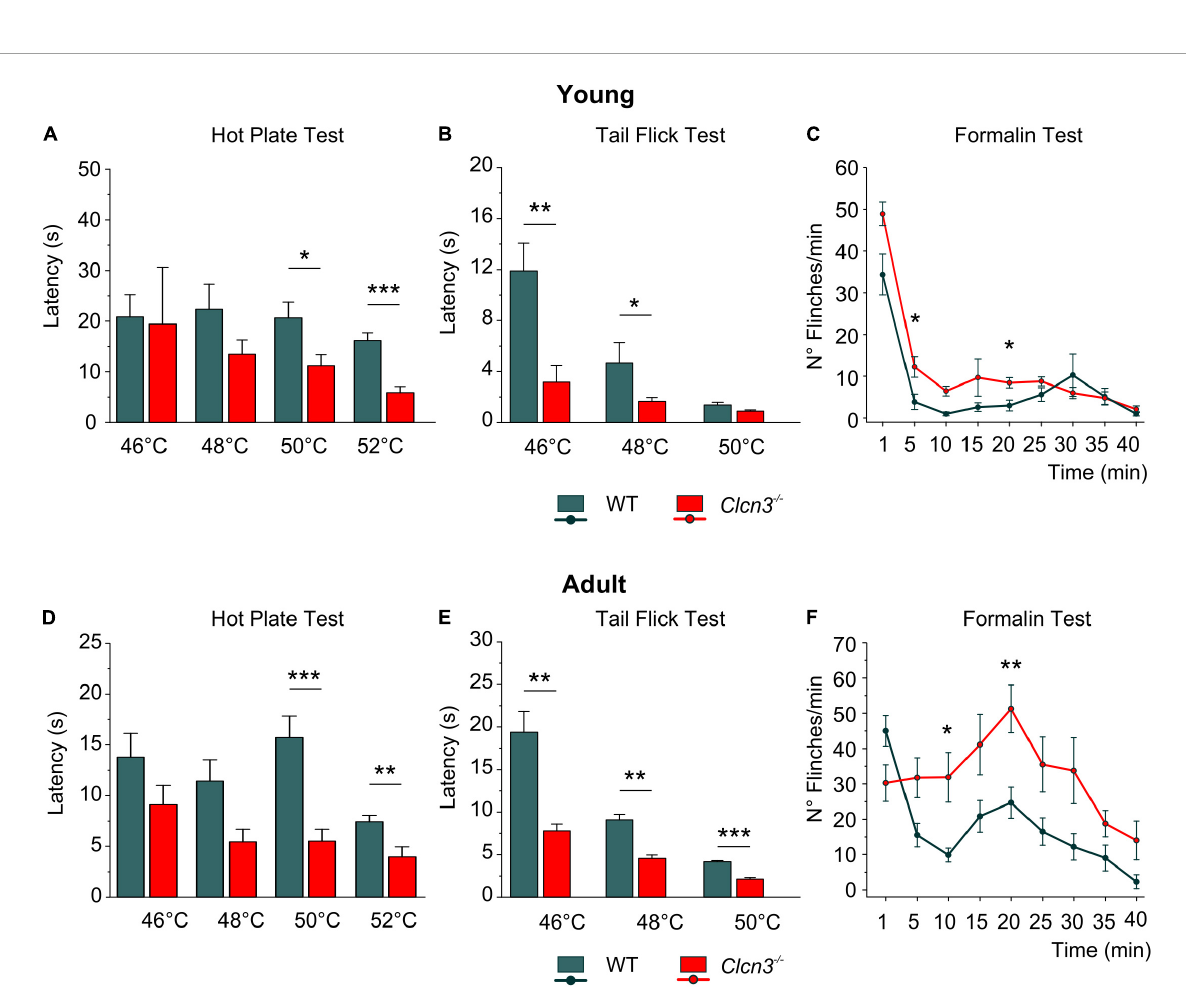
FIGURE1 Acute pain experiments in young P21 (A–C) and adult P60 (D–F) mice show increased thermal sensitivity and lower latencies in mutants compared with wild type (WT) animals. (A) Hot plate test, P21; WT ( n = 7); Clcn3 − / − ( n = 8). (B) Tail flick test, P21; WT ( n = 8); Clcn3 − / − ( n = 9). (C) Formalin test, P21; WT ( n = 8); Clcn3 − / − ( n = 9). (D) Hot plate test at different temperatures, P60; WT ( n = 11); Clcn3 − / − ( n = 13). (E) Tail flick test, P60; WT ( n = 8); Clcn3 − / − ( n = 9). (F) Formalin test, P60; WT ( n = 6); Clcn3 − / − ( n = 8). Statistical significance levels are * p <